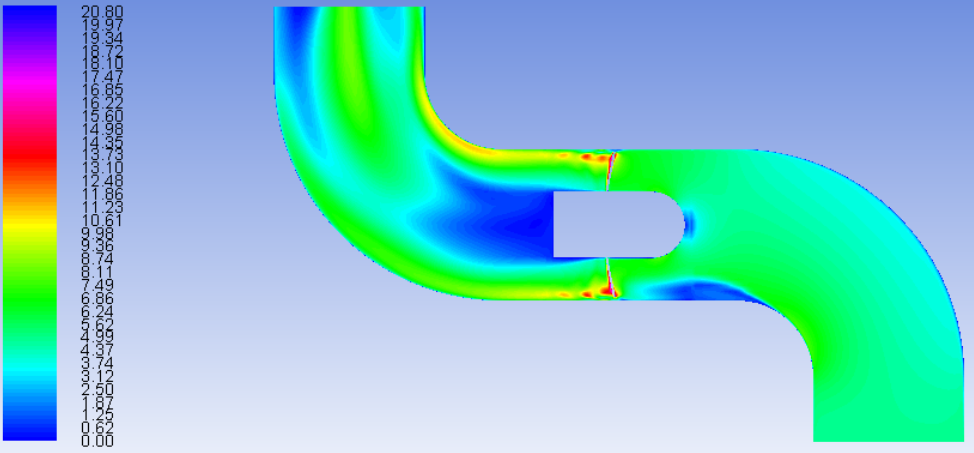
Figure 5. Velocity contours of resolved